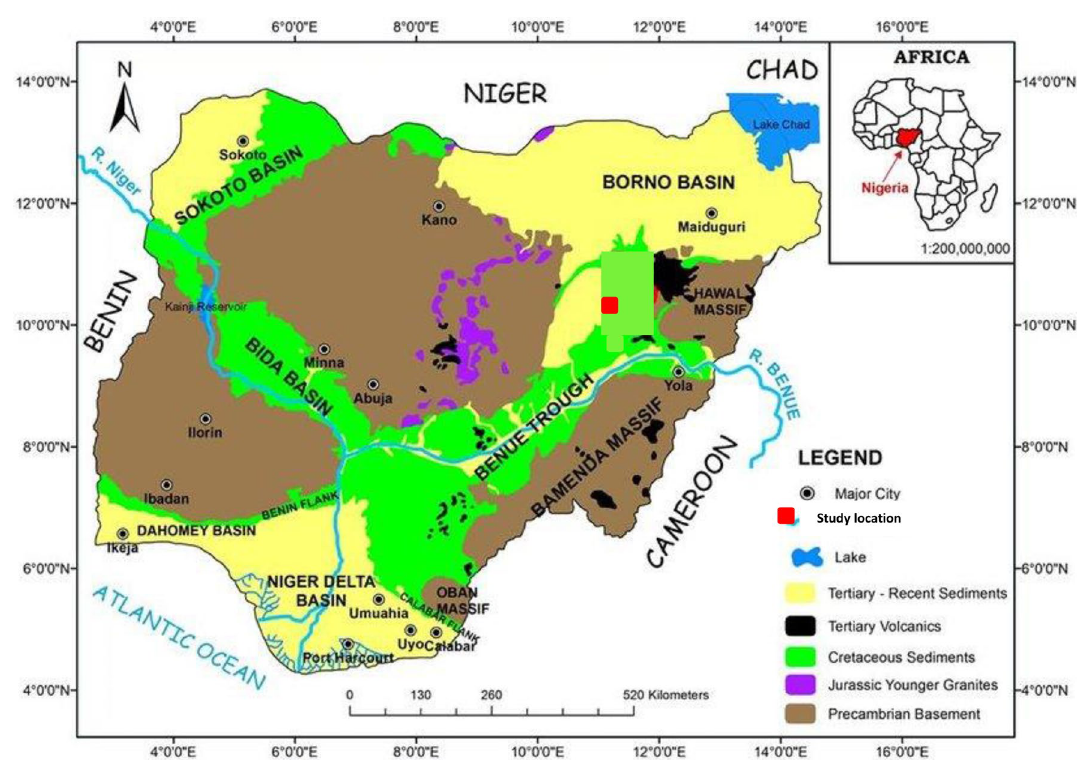
Fig. 1 Geological map of Nigeria showing the Basement Complex, sedimentary basins and the study location (Northern Benue Trough). Modi- fied after Lar et al.